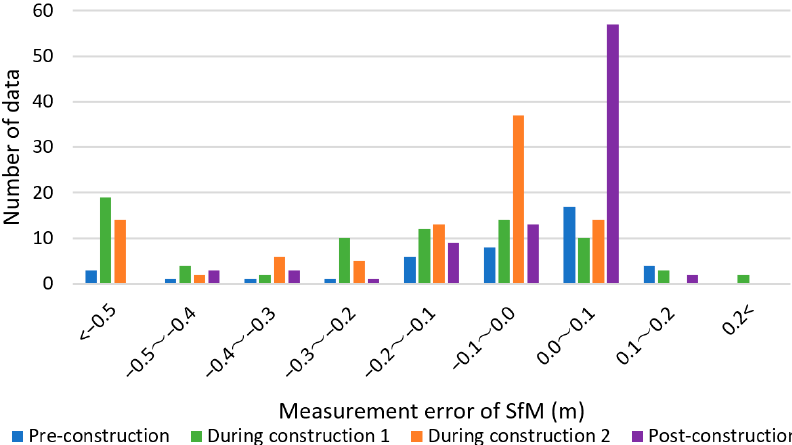
Figure 4. Frequency distributions of height measurement error in SfM analysis.